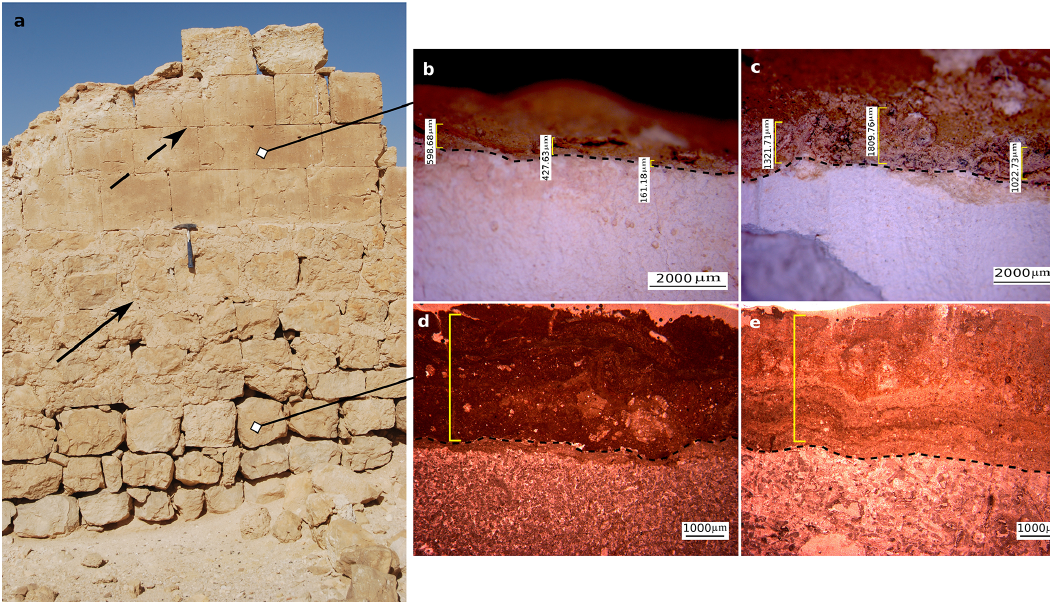
Figure 2. (a) Two rock types were retrieved from a south-facing exterior wall (30cm hammer for scale) in the Byzantine city of Shivta (1700 years old). The upper section of the wall was constructed of chalk blocks (dashed arrow), while the lower section was constructed of limestone blocks joined by plaster (solid arrow); (b) a thin BRC as observed in the chalk blocks from Shivta compared to a thicker BRC as observed in an uncarved chalk rock from the adjacent slopes (c) ; (d, e) limestone BRCs as observed in a sample collected from the city (d) and adjacent slopes (e) . Dashed lines mark the border between the BRC at the top and the host rock at the